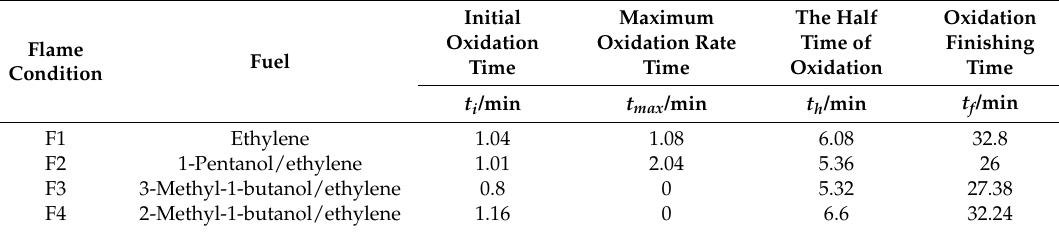
Table 4. Oxidation characteristics of nascent soot particles under different